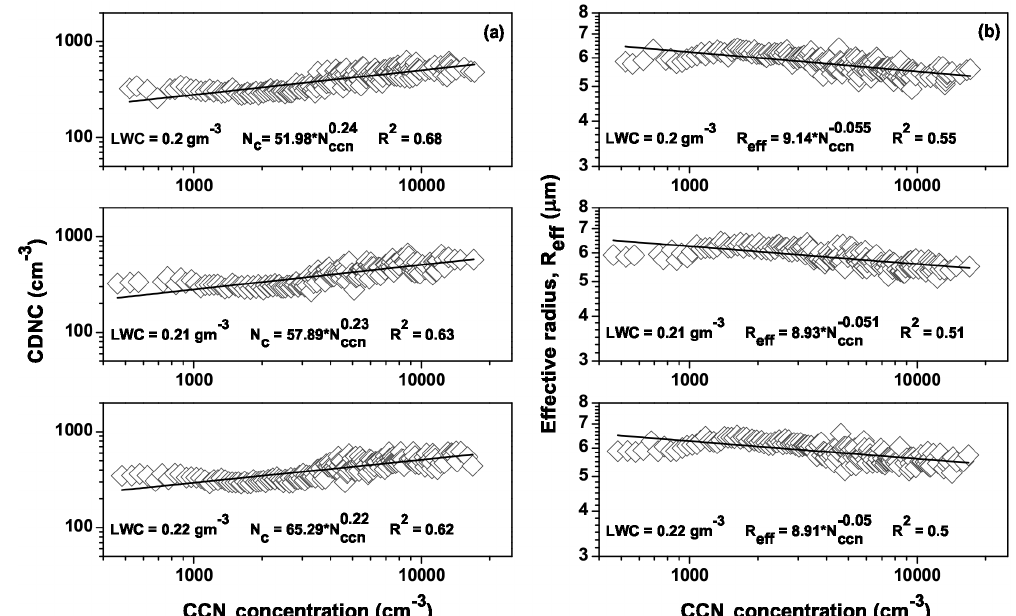
Figure 3. Scatter plot showing relation between cloud condensation nuclei (CCN) concentration measured at 0.6% supersaturation and cloud droplet number concentration (CDNC) and CCN concentration versus cloud effective radius ( R eff ) for three LWC bins (0.20, 0.21, and 0.22gm − 3 ) .